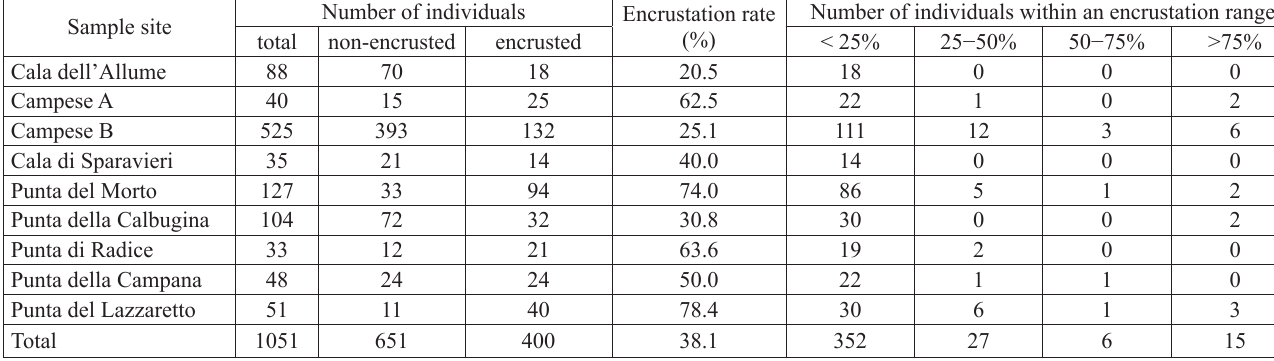
Table 5. Encrustation rates of Echinocyamus pusillus with respect to sample